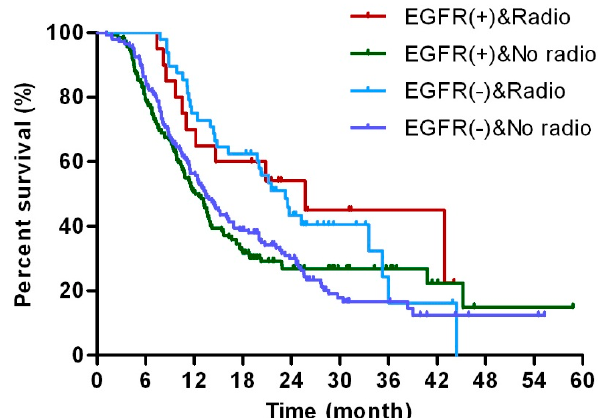
Figure 3. Subgroup analysis of adjuvant chemotherapy. Kaplan–Meier estimates of survival of patients who received adjuvant chemotherapy (Chemo) or refused chemotherapy (No chemo) according to EGFR status: EGFR (+) or EGFR ( − ).